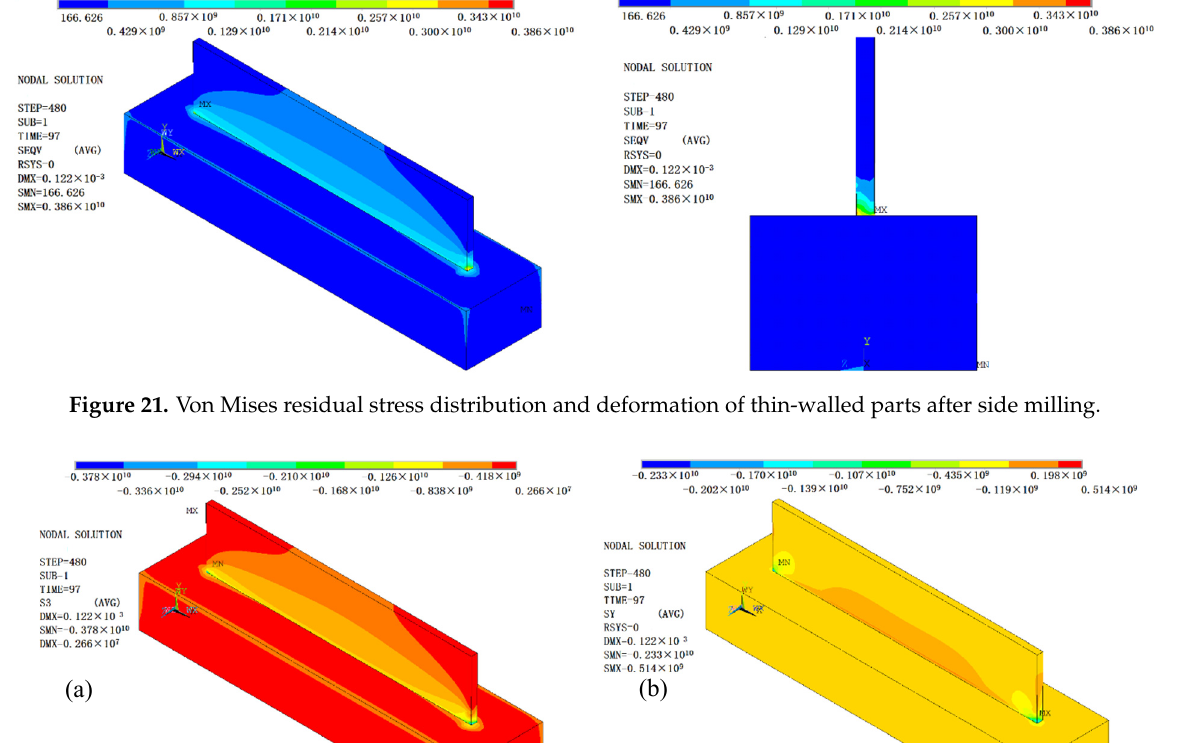
Figure 23. Comparison of deformation ( a ) and deformation statistics ( b ) before and after milling on the top of laser cladding thin-walled parts.